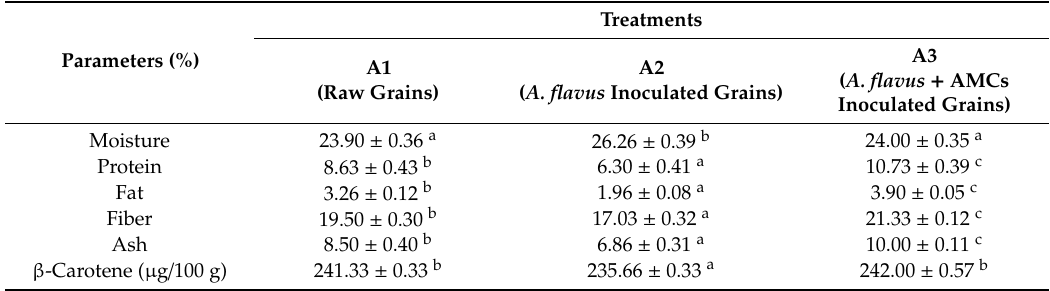
Table 1. Proximate analysis and β -carotene determination of un-treated and AMC-treated maize grains.